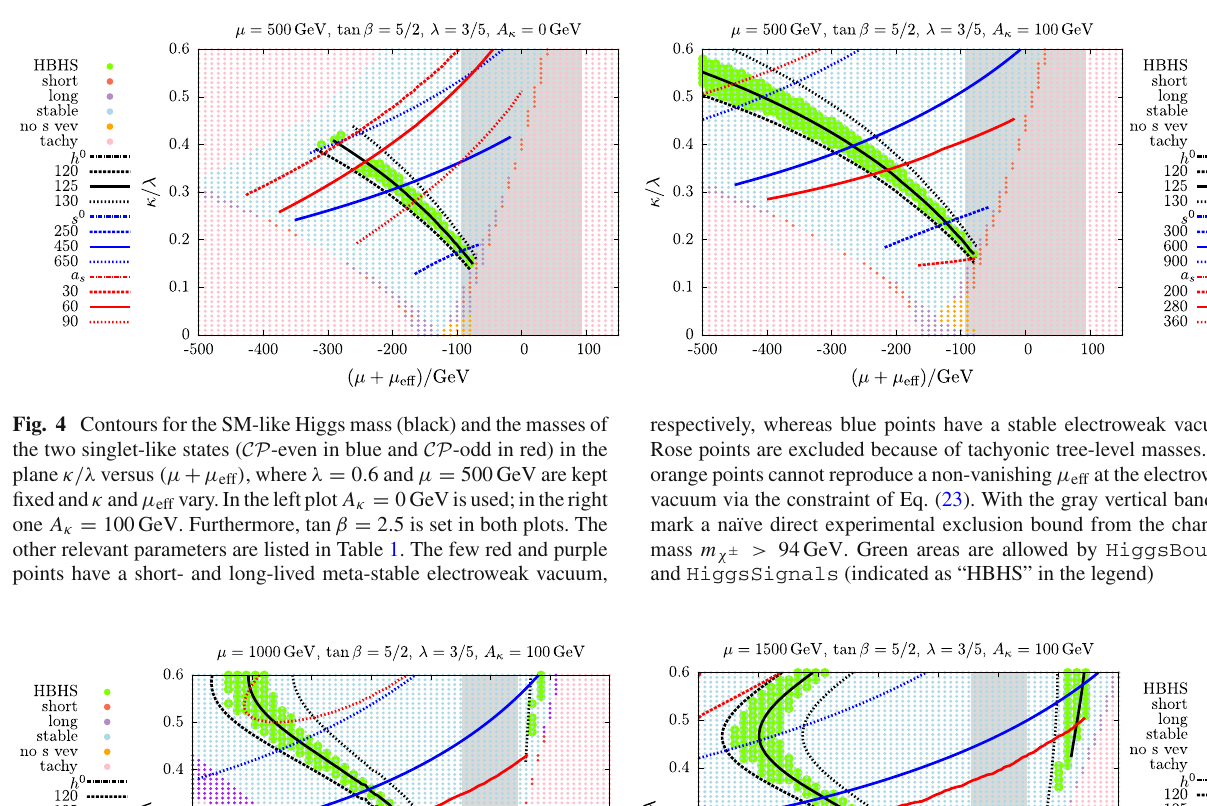
Fig. 5 The same as Fig.4, except that A κ = 100GeV is used in both plots, and the parameter μ is set to μ = 1000GeV (left) and 1500GeV